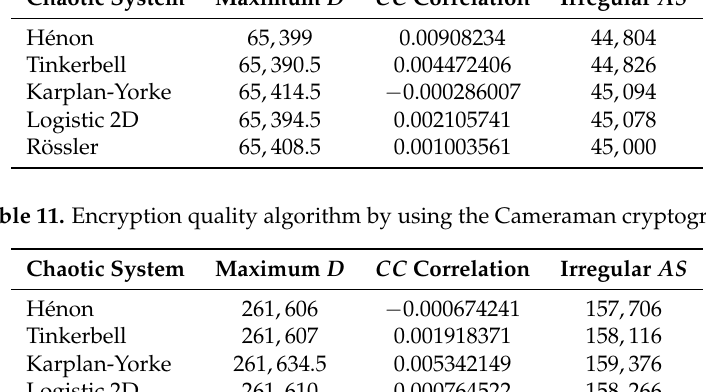
Table 10. Quality of the encryption algorithm by testing Lena’s cryptogram. Chaotic System CC Correlation